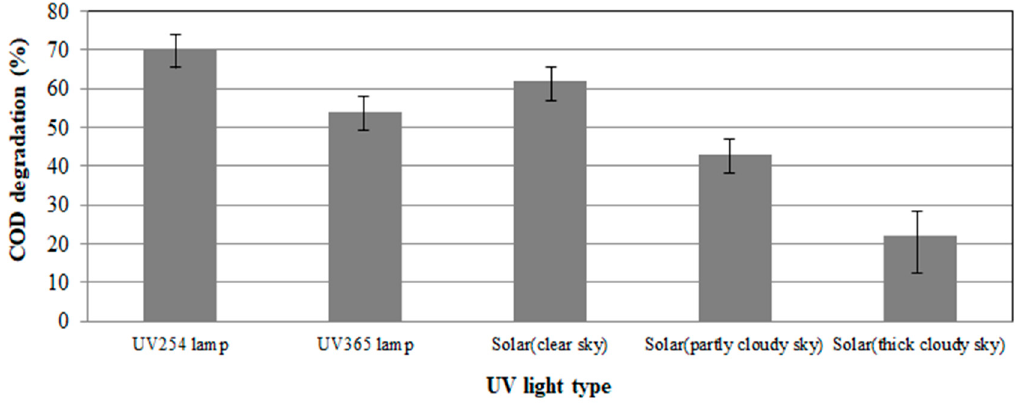
Figure 8. Effect of UV light types on COD removal in photo-assisted Fenton oxidation (pH = 3.5, Fe 2+ = 0.01 M, H 2 O 2 = 0.1 M).